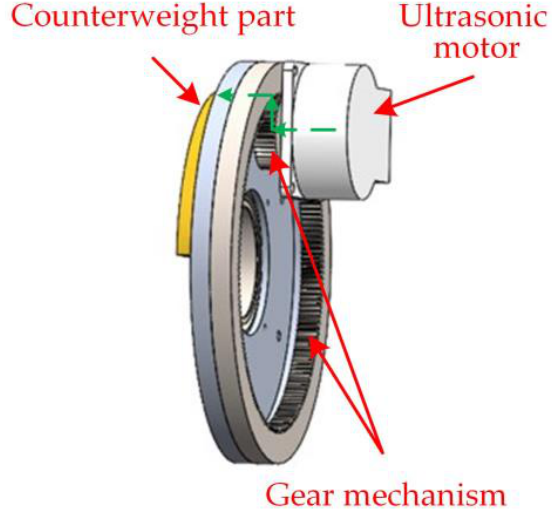
Figure 9. The power transmission path of the actuator.